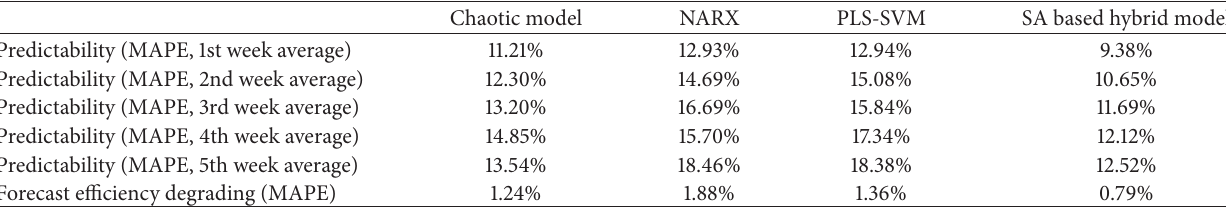
Table 1: Comparison of three models and SA based hybrid forecast. Forecast efficiency degrading means the average degradation of the neighboring week in MPAE.